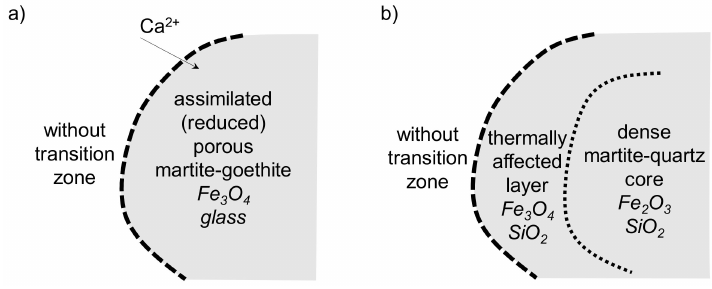
Figure 17. Ore assimilation scheme in the SM-F